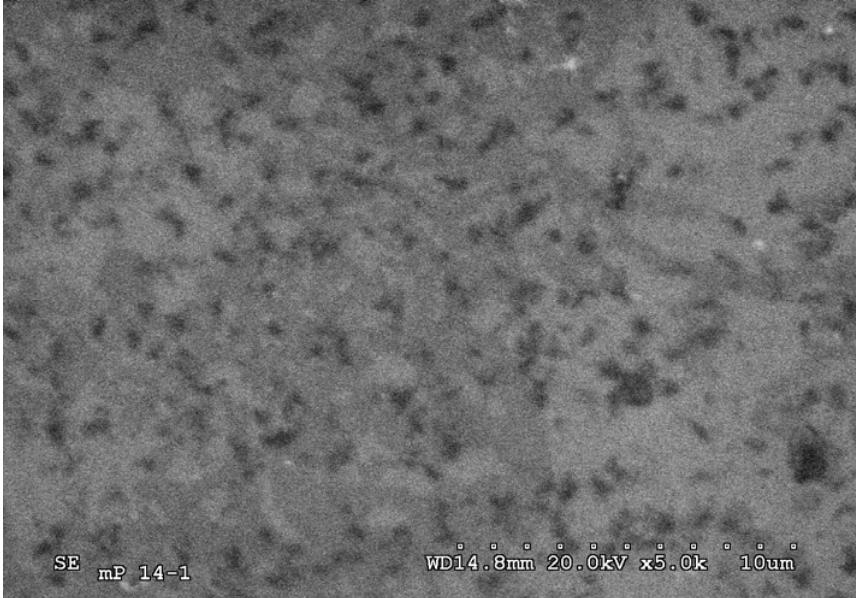
Figure 4. Scanning electron microscopy (SEM) images of the surface of nanoPS immediately after the biofuntionalization process (top), and after immobilization of antibodies (100 μ g/mL) plus fragments of E. coli bacterium